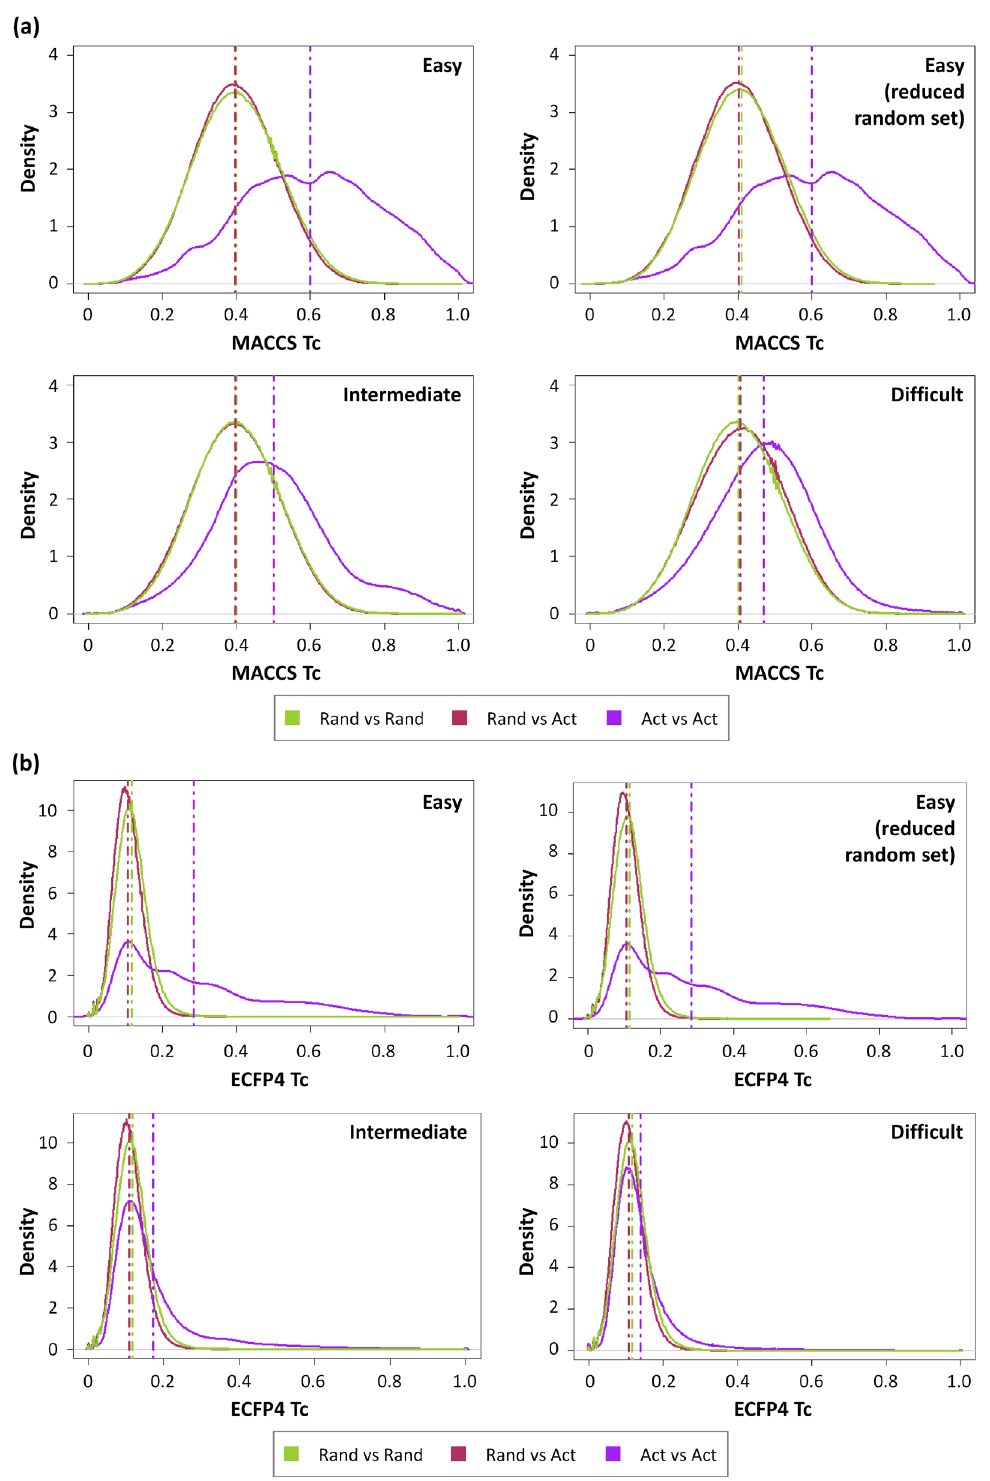
Figure 4. Distribution of similarity values for different activity class categories. Density plots of Tc values are shown for similarity comparison using ( a ) MACCS and ( b ) ECFP4 according to Figure 2. In this case, Tc value distributions were separately recorded for each activity class category (easy, intermediate, and difficult). In addition, easy activity classes were compared to a reduced random set of 1000 ZINC compounds (reported in the upper right